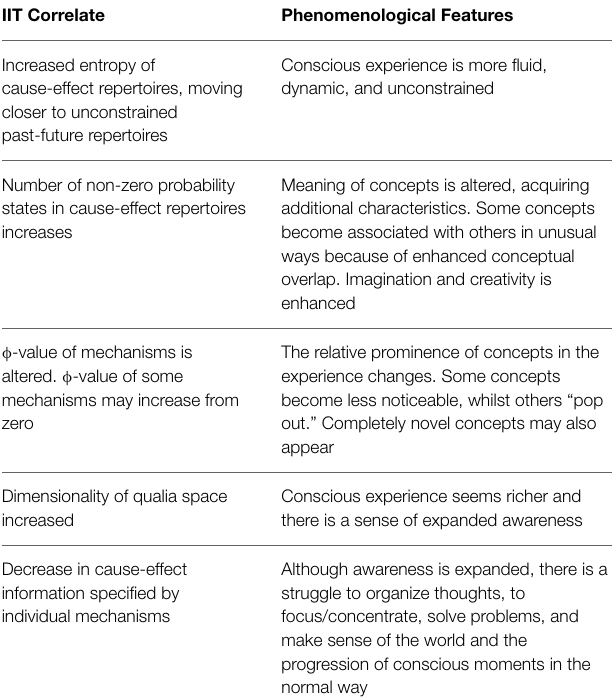
TABLE 1 | Phenomenological features of the psychedelic state and their IIT